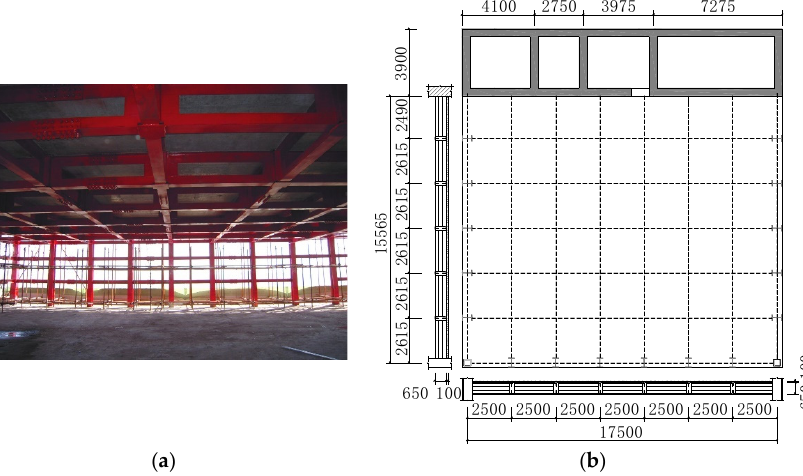
Figure 17. Structural diagram of the floor: ( a ) site photo; ( b ) plane